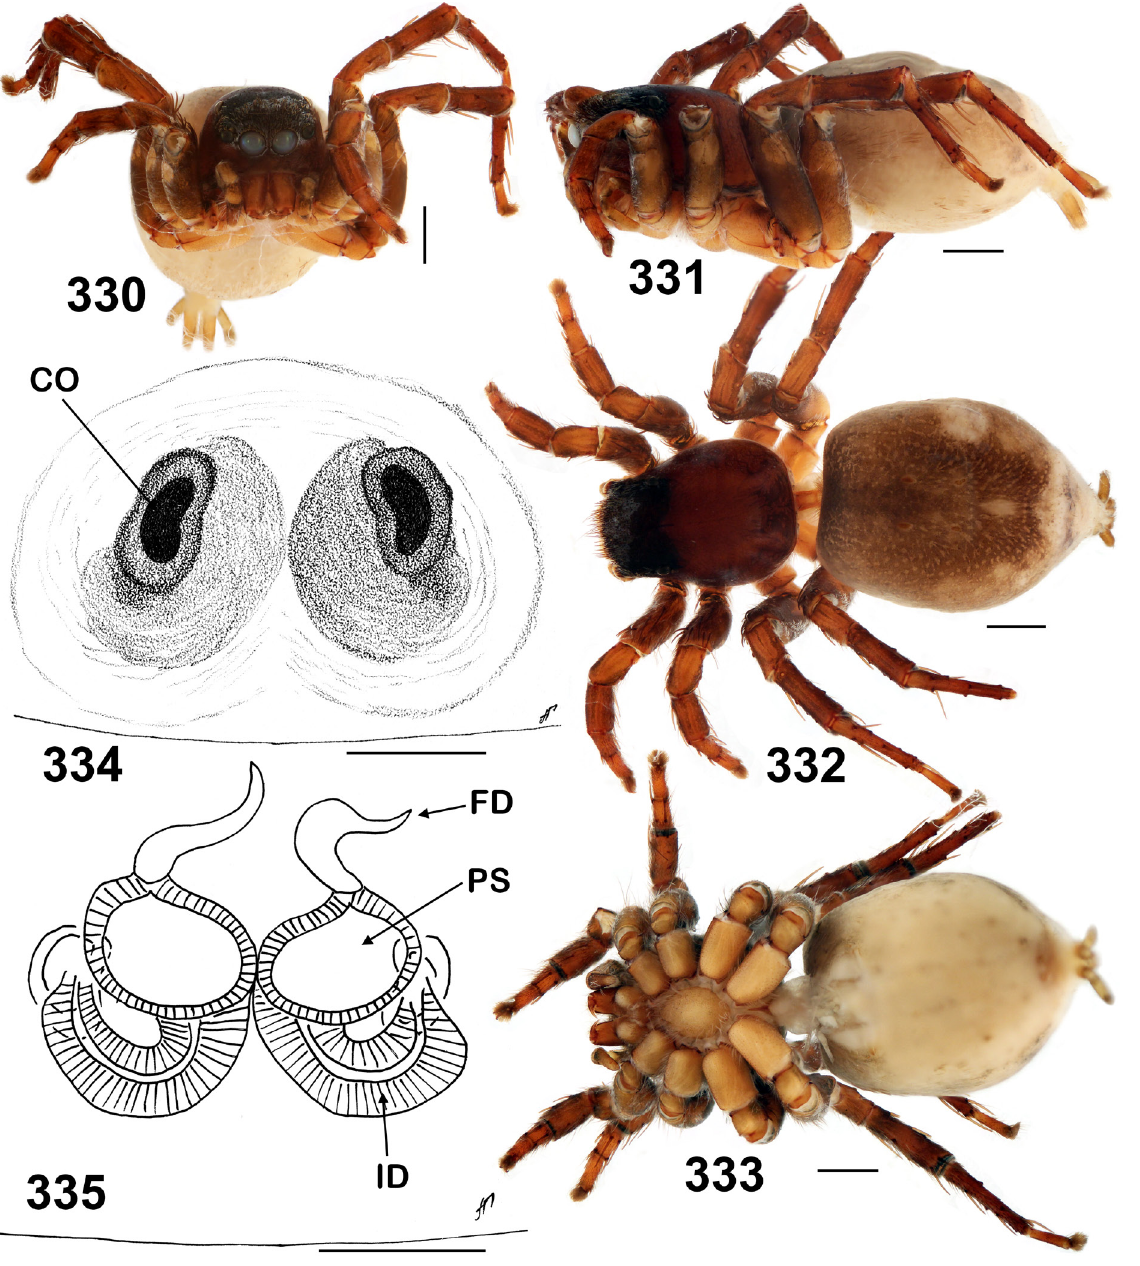
Figs 330–335. Stenaelurillus latibulbis Wesołowska, 2014, ♀ from Zambia (Luambe) . 330–333 . General appearance. 334 . Epigyne, ventral view. 335 . Spermathecae, dorsal view. Abbreviations: see Material and methods. Scale bars: 330–333 = 1 mm; 334–335 = 0.1